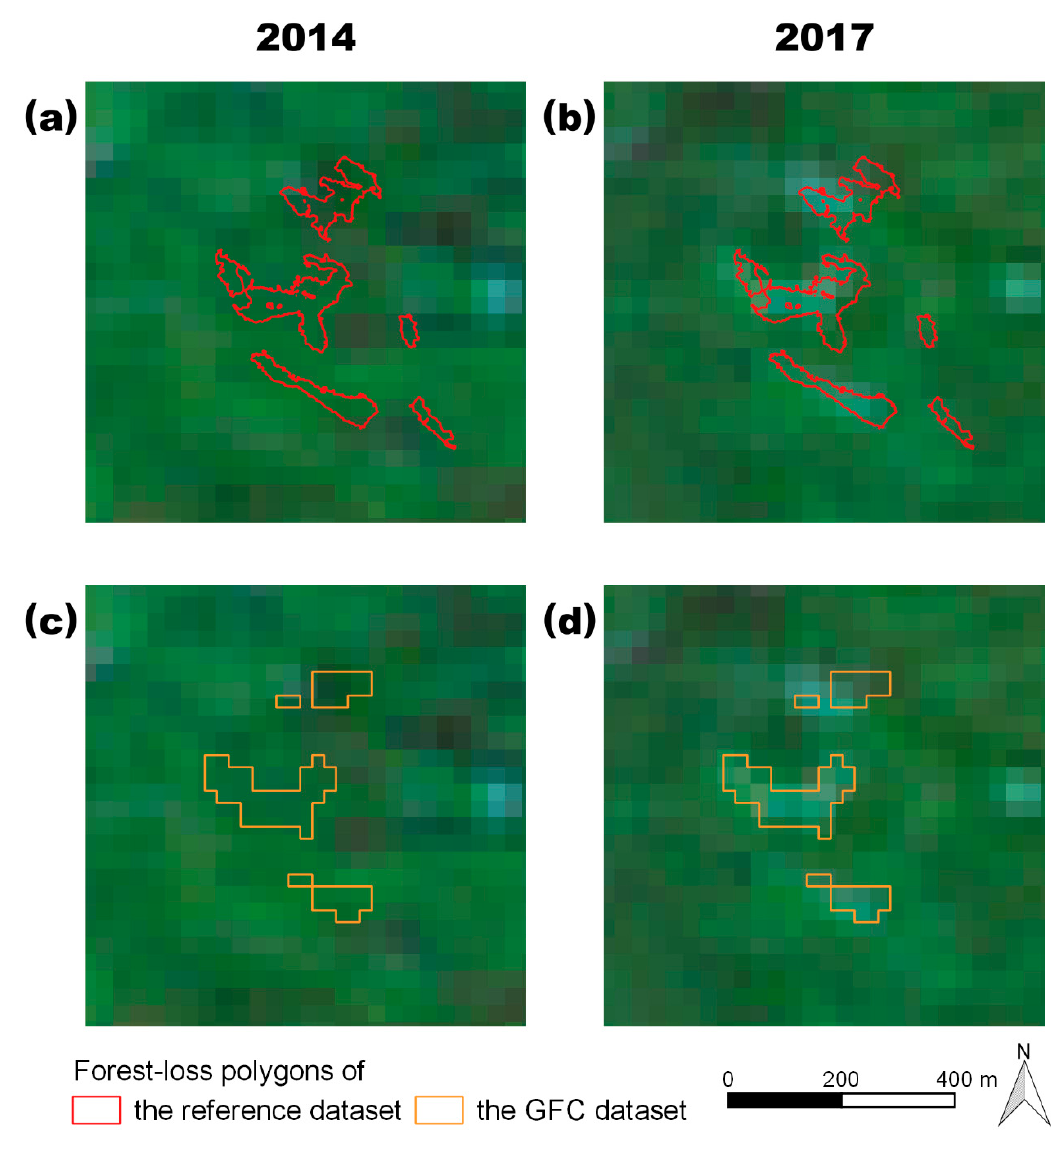
Figure 2. Examples of forest-loss polygons of ( a , b ) the reference dataset and ( c , d ) the GFC dataset with the Landsat composite images in ( a , c ) 2014 and ( b , d ) 2017 that cover between June 2014 and December 2016. The Landsat composite images were used only for visualization.